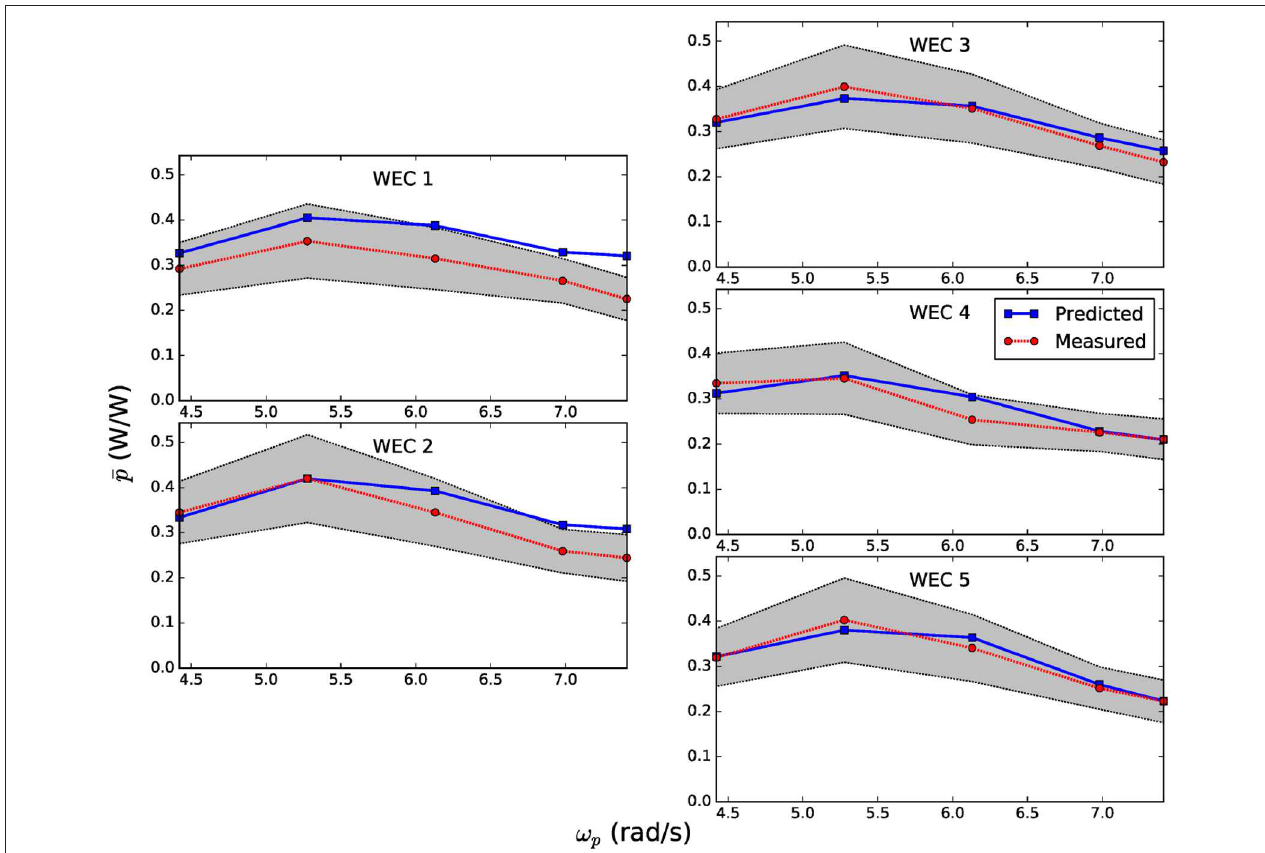
FIGURE 9 | Predicted and measured capture factor for the power absorption of an array of five WaveStar models at a scale of 1:20 in irregular waves (Mercadé Ruiz et al., 2017); see Figure 2 for the experimental set-up.